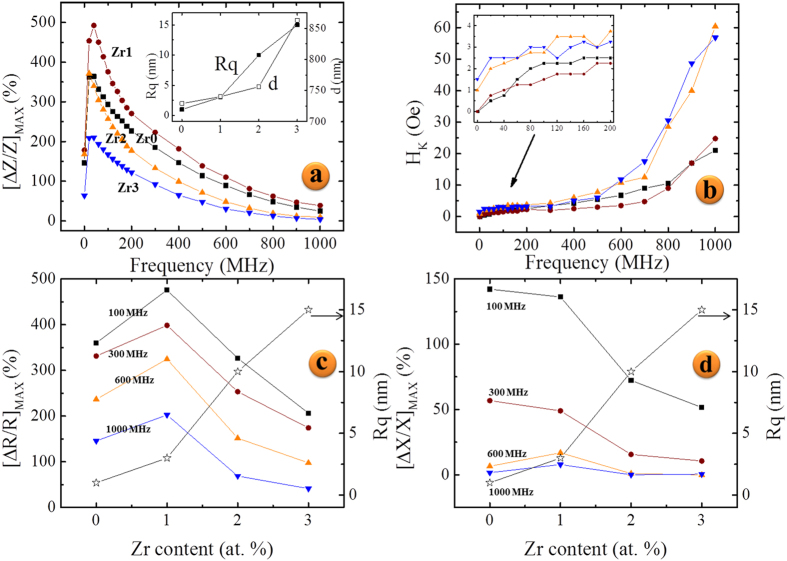
Maximum change in impedance (a), anisotropy field (b), maximum change in resistance of Co68.15Fe4.35Si12.25B15.25-xZrx microwires with x = 0–3 denoted by square, circle, triangle, and inverted triangle symbols, respectively. Inset of (a) shows the correlation of average surface roughness Rq with domain period d. Inset of (b) shows zoomed in portion. (c) The maximum change in resistance and (d) the maximum change in reactance as a function of Zr content at selected frequencies. The right axis of (c,d) is the domain period denoted by star symbol.